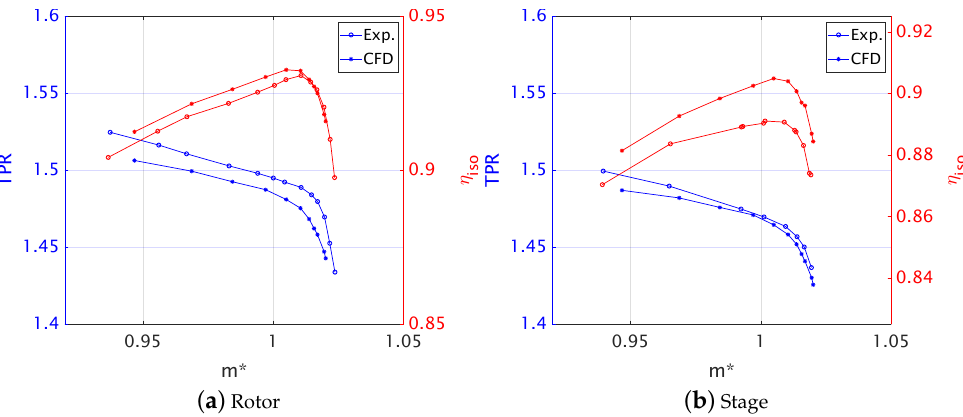
Figure 5. Fan and OGV stage characteristic maps a N c =